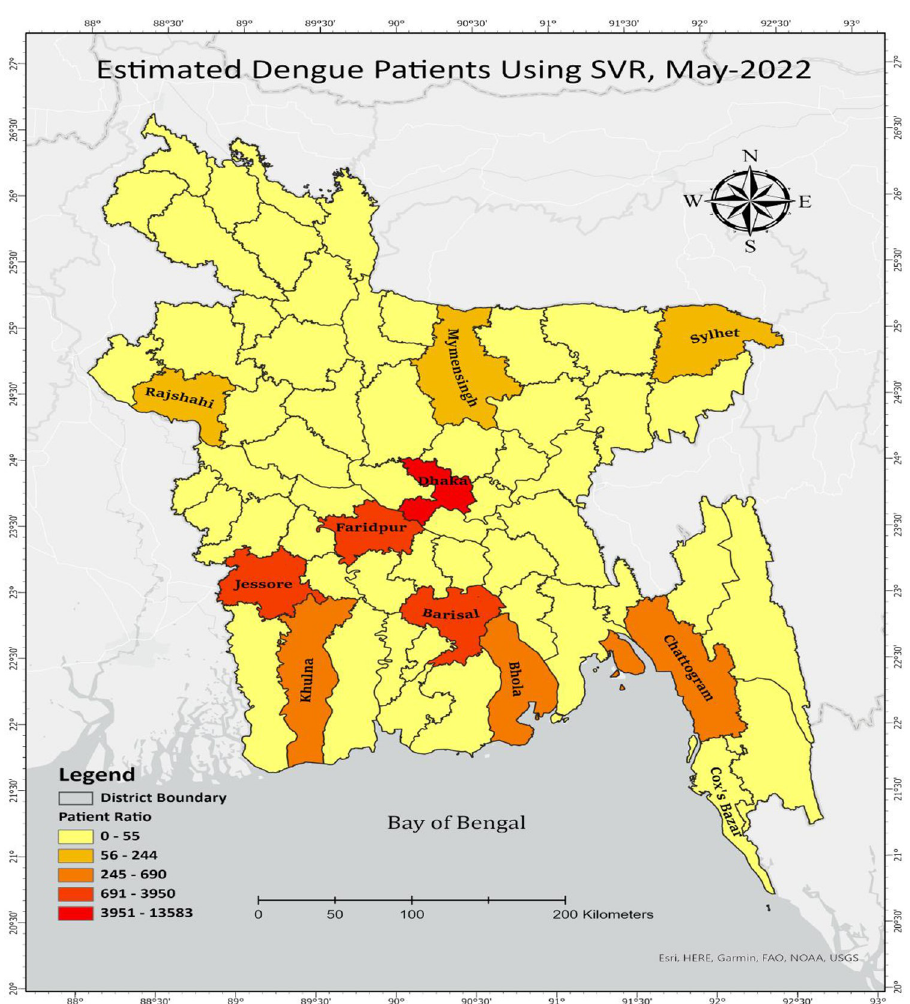
Fig 6. Predicting the dengue patients in 11 different cities of Bangladesh from Aug 2021 to May 2022 using Support Vector Regression (SVR).